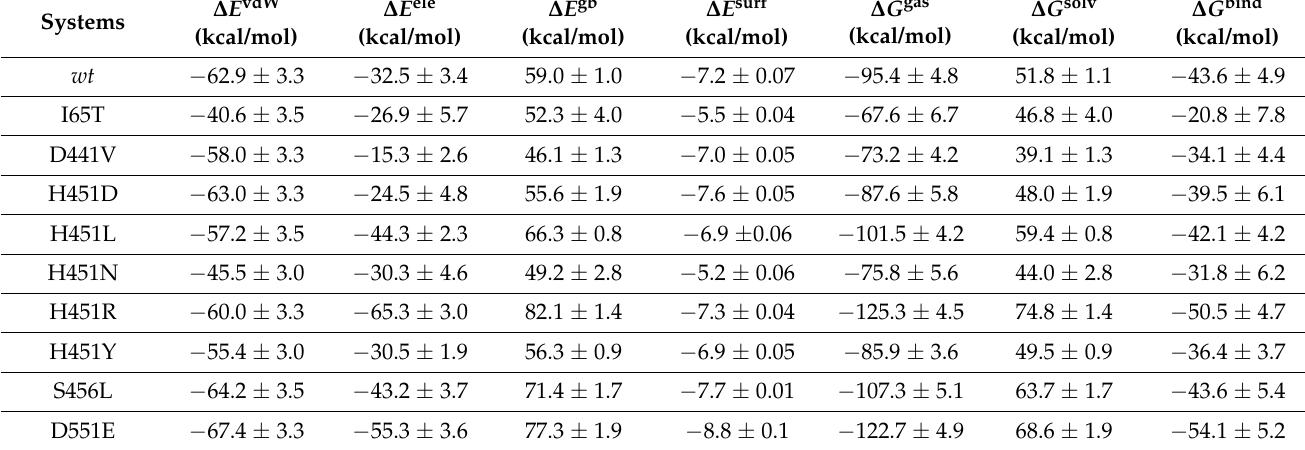
Figure 6. Per-residue decomposition plots showing energy contributions of RIF interacting residues. ( A ) Van der Waals energy decomposition. ( B ) Electrostatic energy decomposition. Table 1. The relative binding affinities of RIF against the wt and mt Mtb